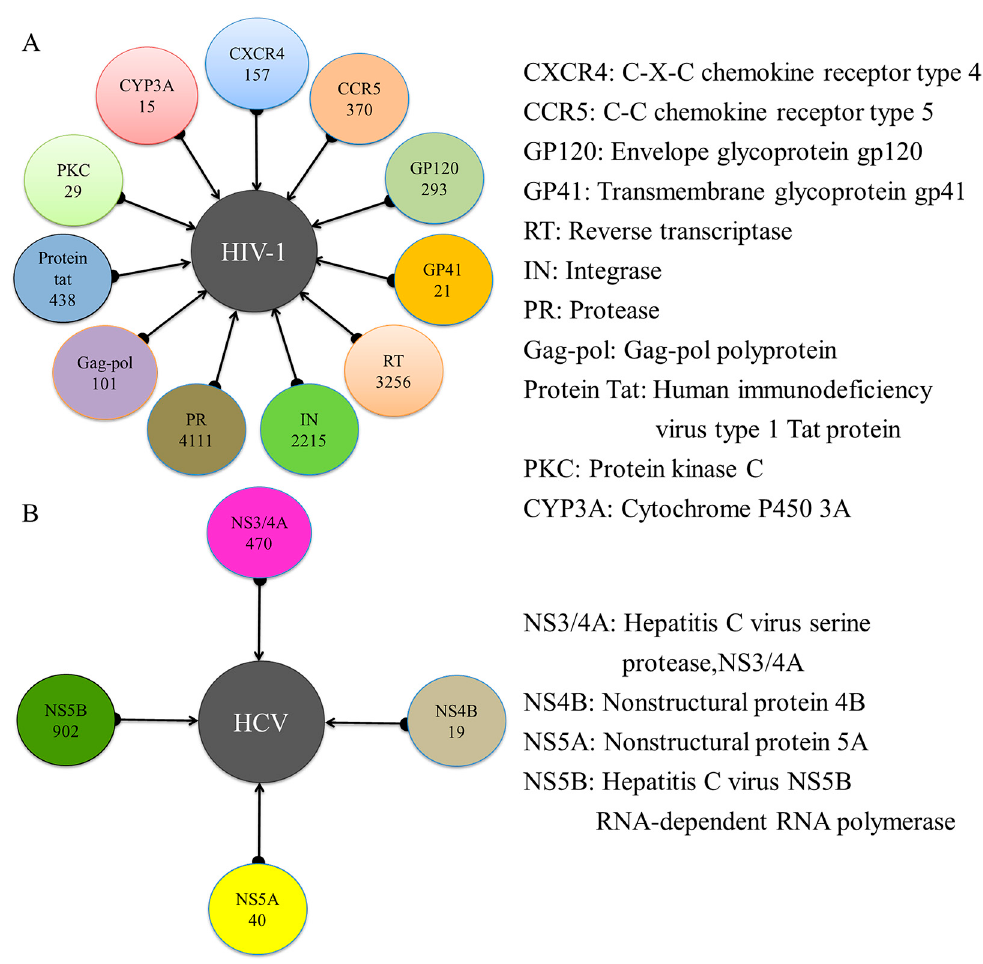
Figure 2. Overview of the targets related to HIV-1 ( A ) and HCV ( B ) and the total number of active compounds identified for each target.